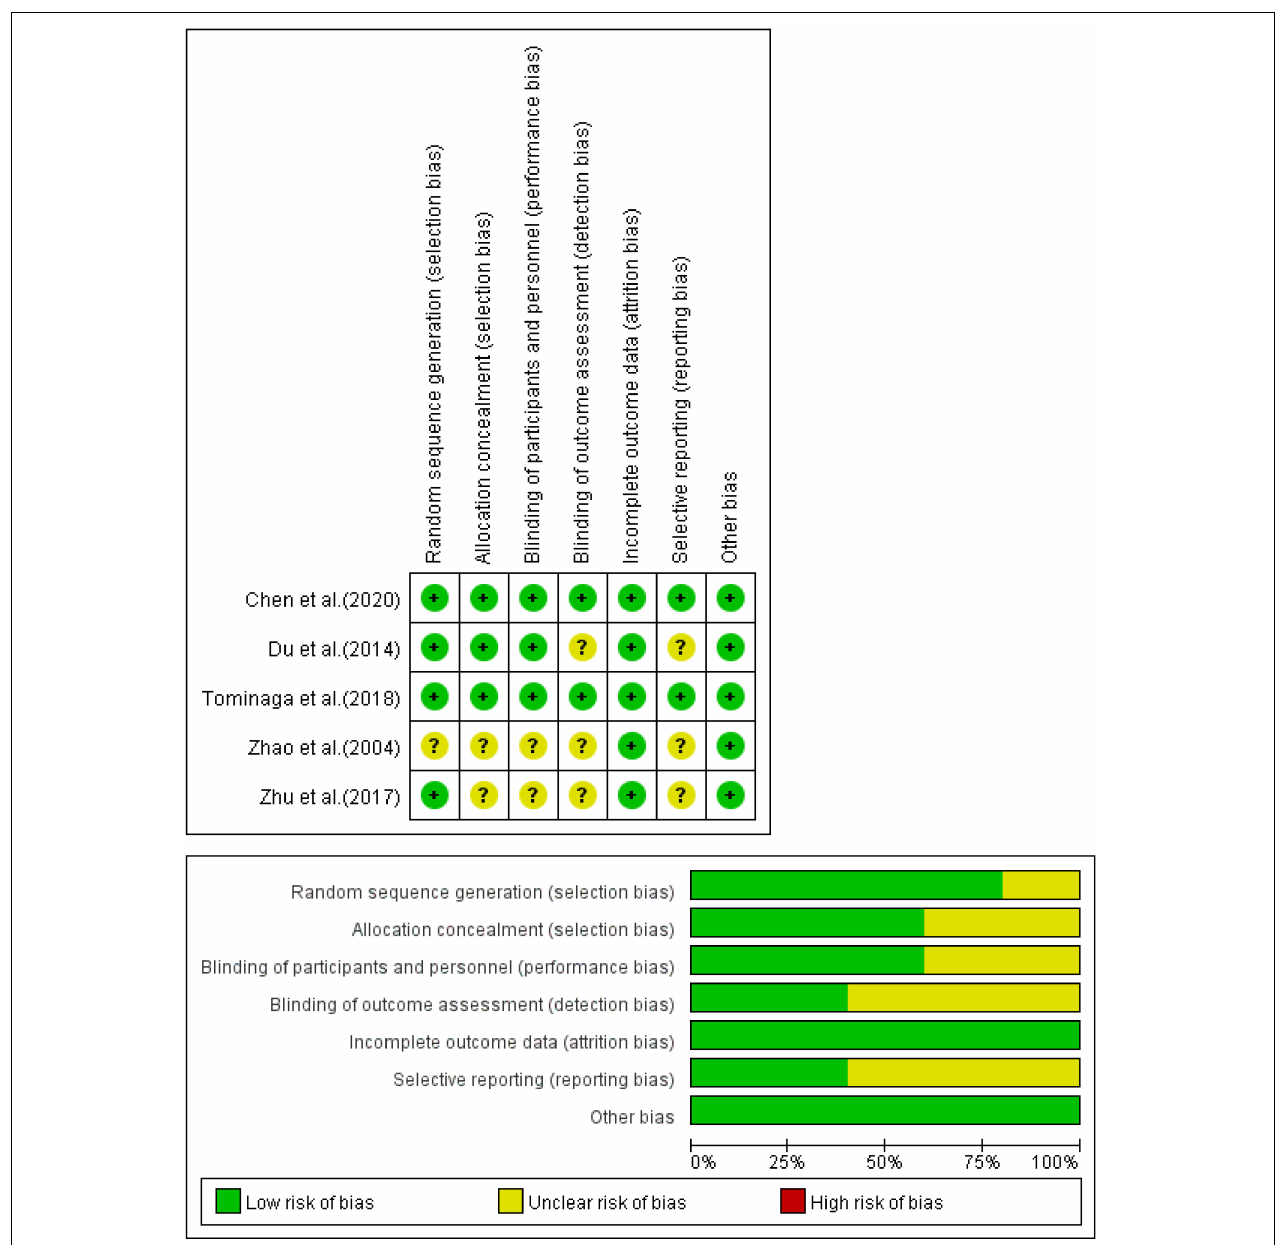
FIGURE 2 | Assessment of the risk of bias of CHM vs.